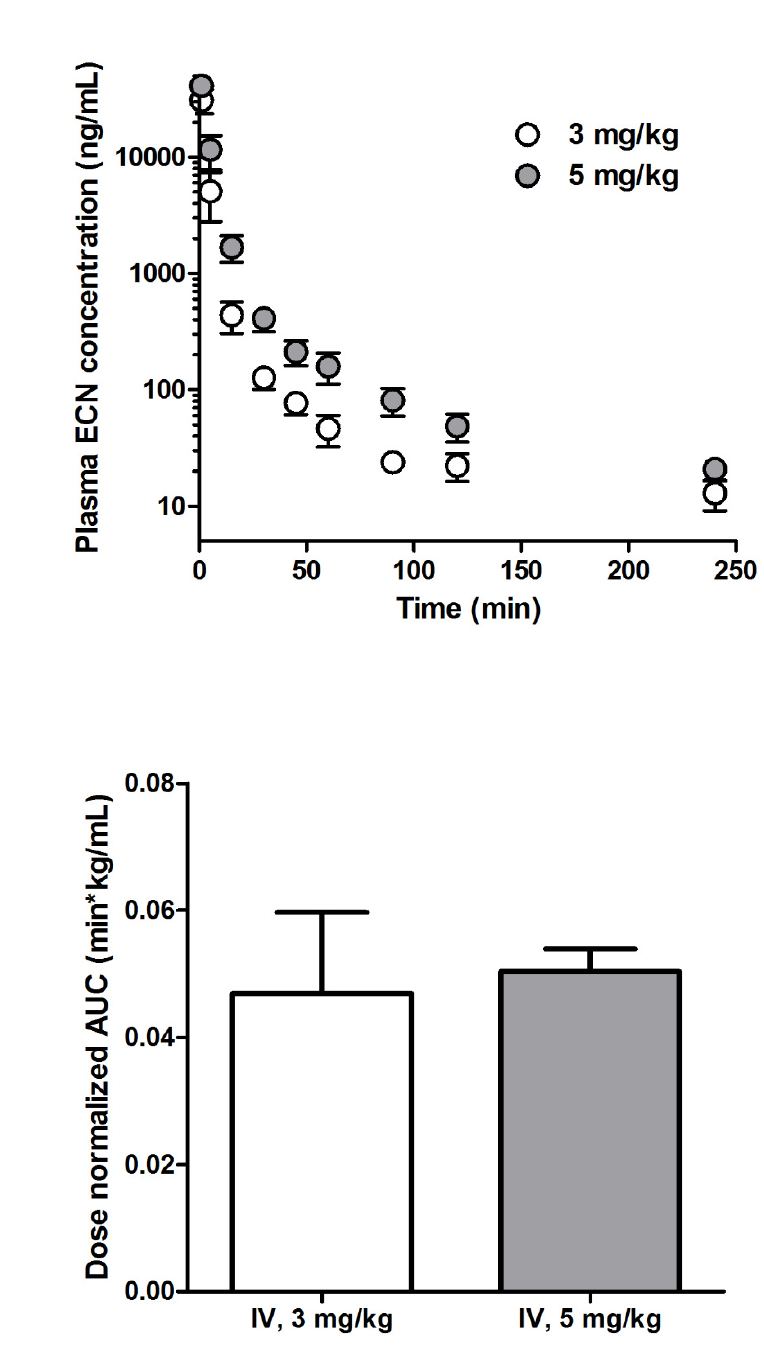
Figure 4. The ECN pharmacokinetics in rats was studied. Plasma concentration–time profiles of ECN after intravenous (IV) administration of a 3 or 5 mg/kg dose ( a ) and the dose-normalized AUC last value of each group ( b ) are presented. Each point indicates mean ± SD ( n = 3).